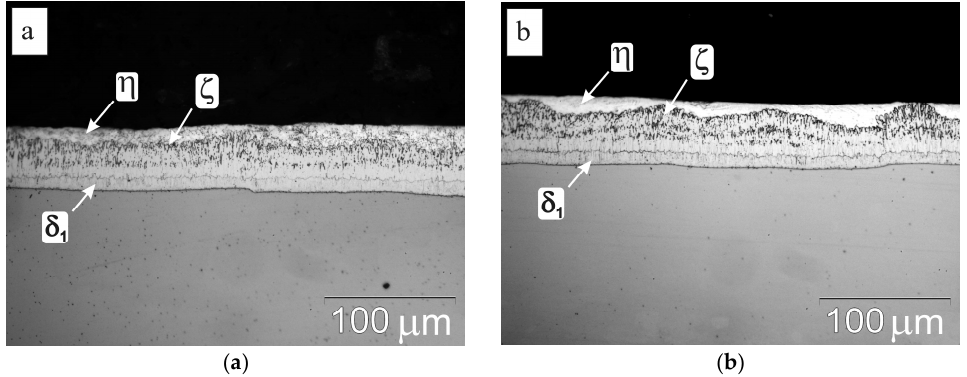
Figure 2. The view of a cross-section of coatings produced in Zn-AlNiBi bath ( a ) and “pure” zinc bath ( b ) [17] on samples for corrosion research.